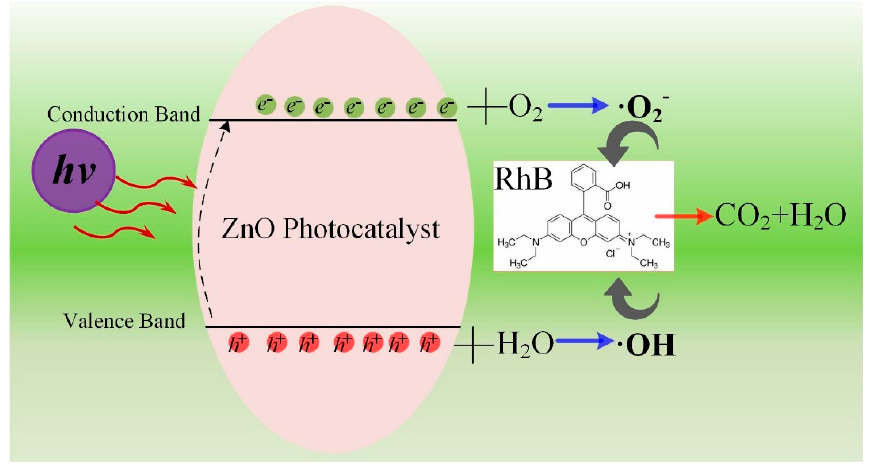
Figure 10. Schematic of the mechanism of photodegradation of organic dyes by the hierarchical ZnO microsphere catalyst.